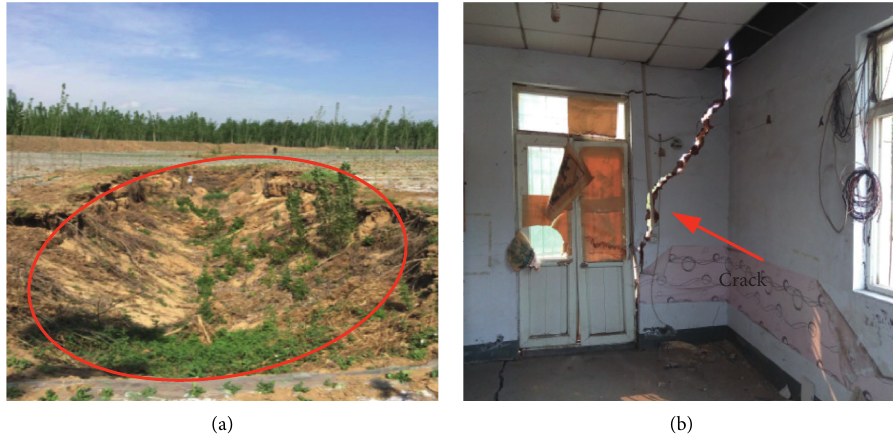
Figure 1: Damages of surface subsidence caused by underground coal mining. (a) Collapse pit. (b) Building damage.